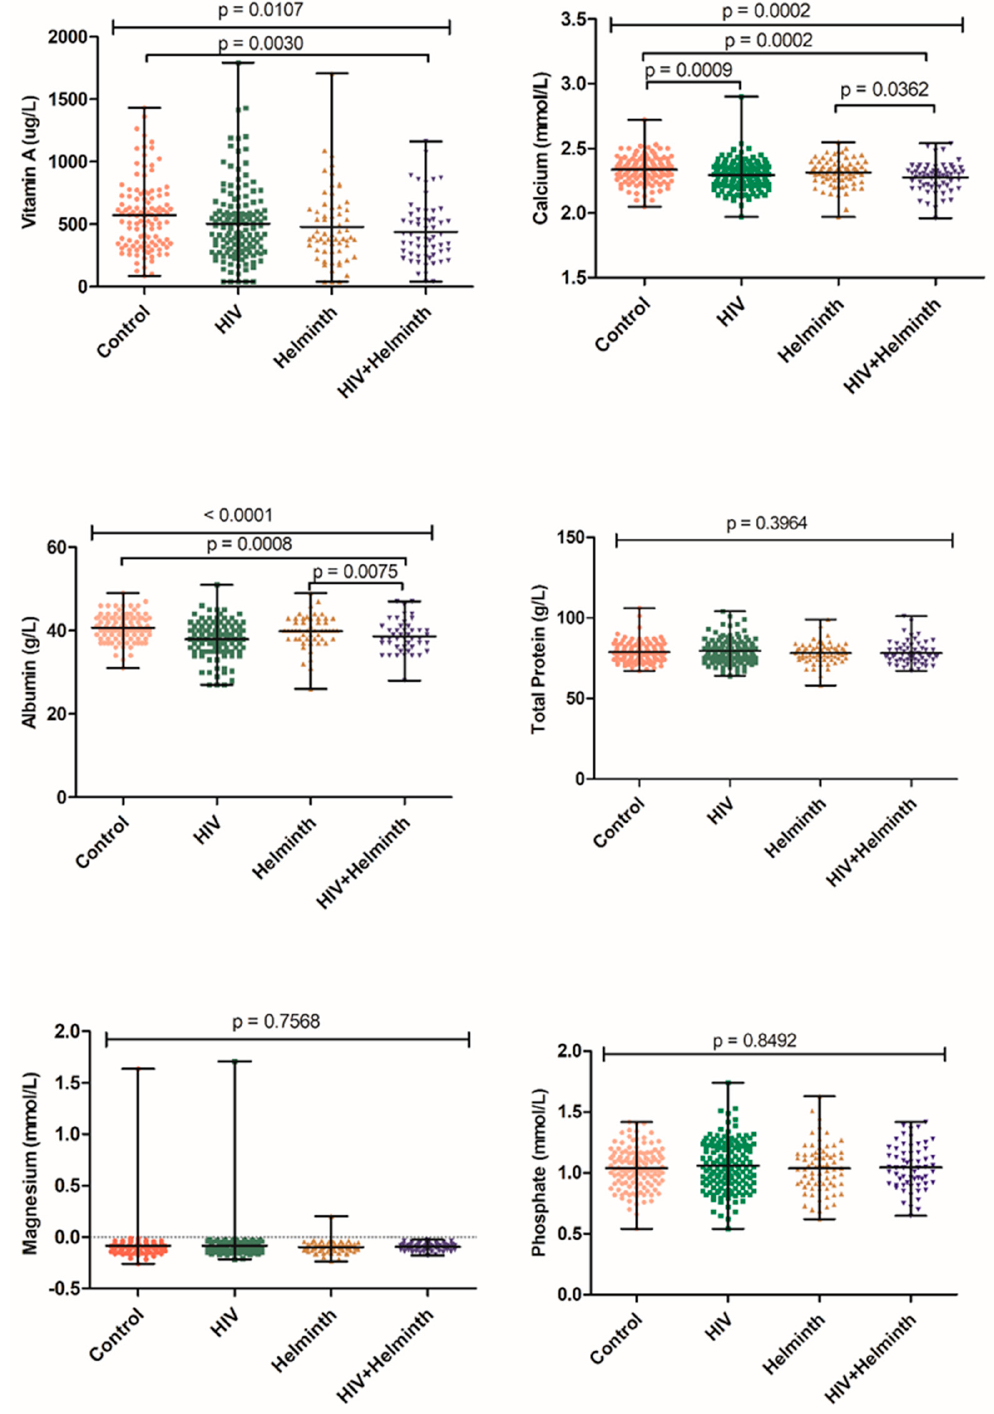
Figure 4. Univariate association of vitamin A, calcium, albumin, total protein, magnesium, and phosphate levels of HIV- and helminth-infected and uninfected control groups. “Control” refers to the HIV/helminth uninfected group.